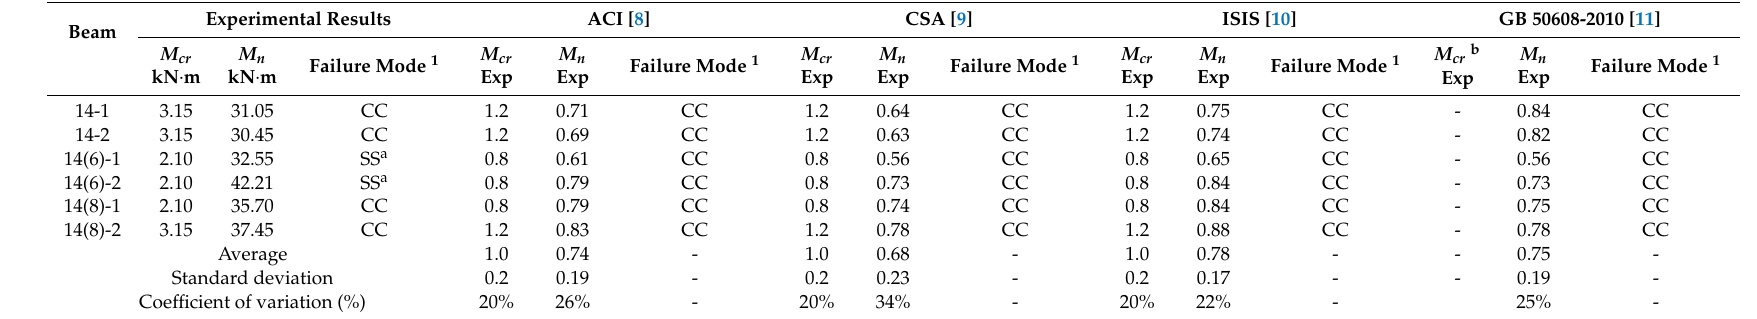
Table 4. Experimental and predicted cracking and ultimate moments.